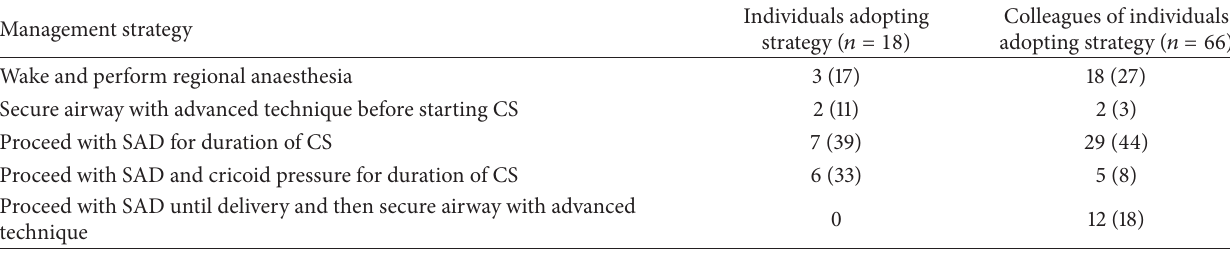
Table 2: Management strategies of delegates who have personally experienced failed intubation and know colleagues that have experienced the situation.